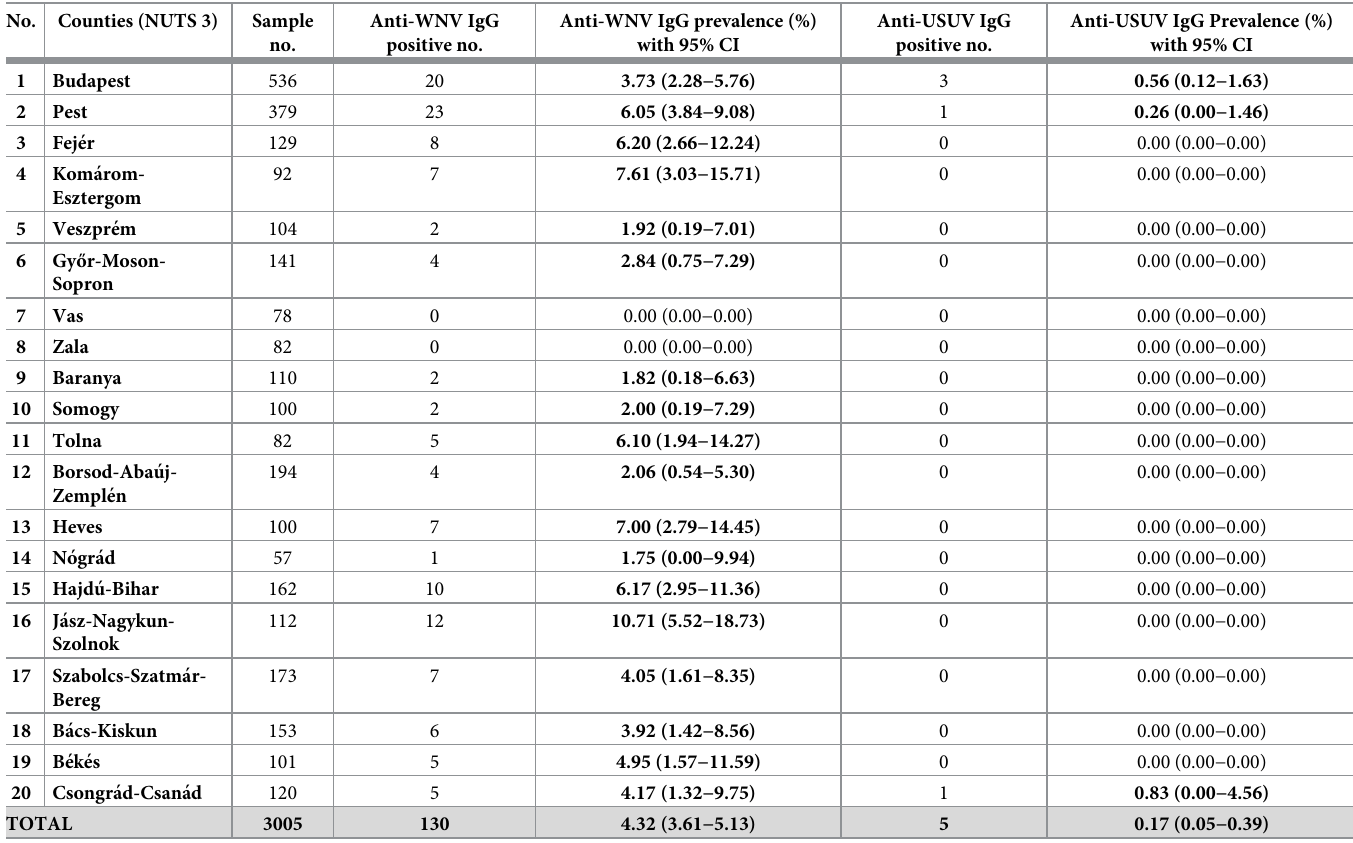
Table 2. West Nile and Usutu virus seroprevalence data in Hungary at NUTS 3 level, in 2019. No. Counties (NUTS 3) Sample